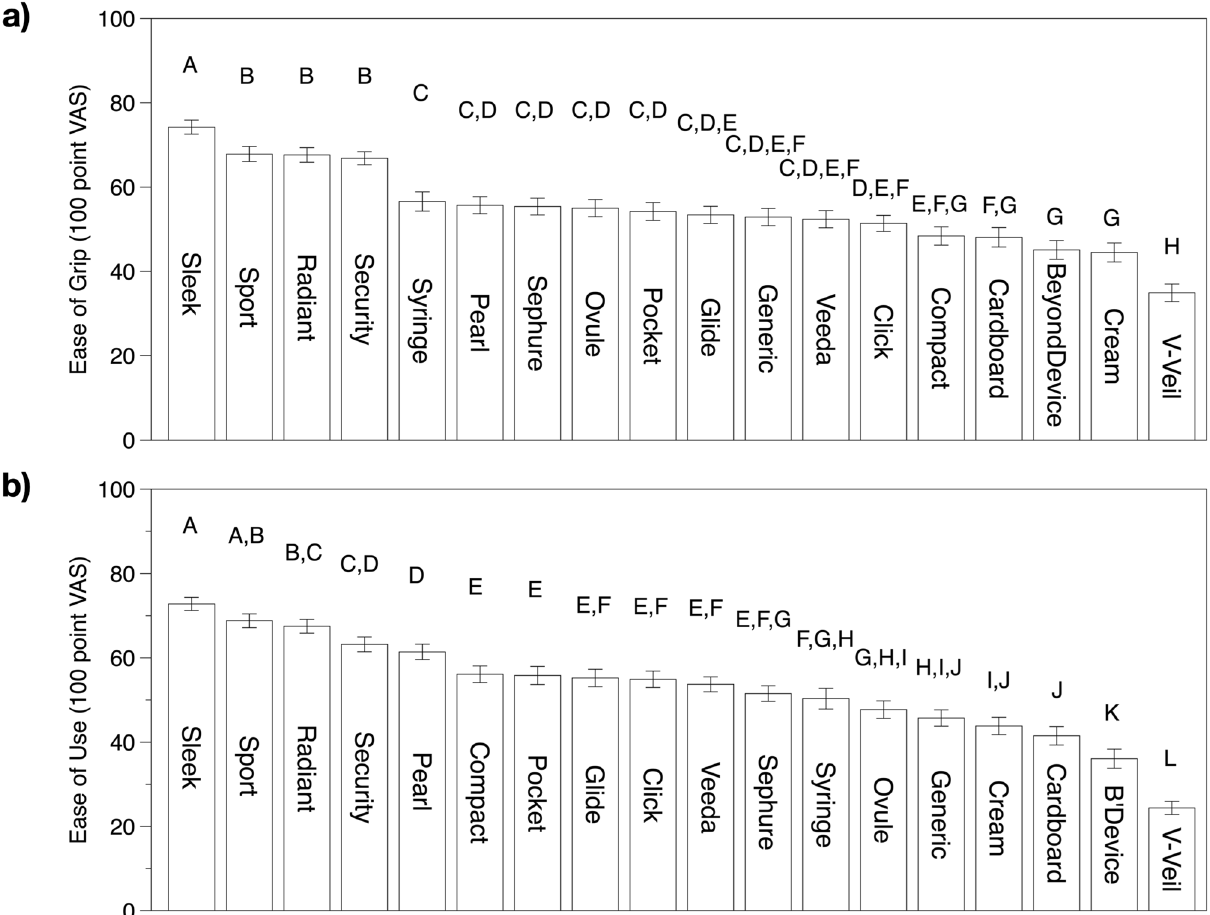
Figure 5. Means and standard errors for ease-of-grip ratings ( a ) and ease-of-use ratings ( b ). Short applicator names correspond to Fig. 1. Ratings were collected on a 100-point visual analog scale where verbal anchors were placed at 10 (Not at all easy) and 90 (Very easy); a midpoint was not provided. Within a panel, mean ratings with a letter in common are not significantly different at α = 0.05 (Fisher’s